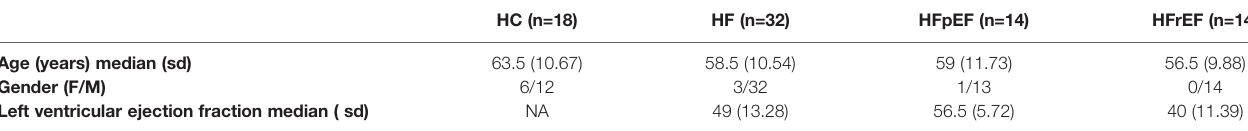
TABLE 1 | Human subject demographics